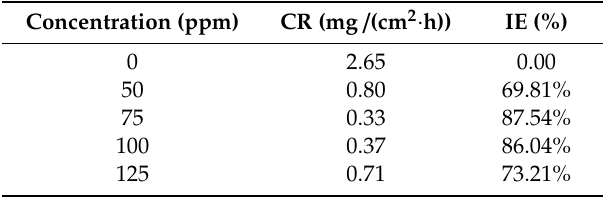
Table 1. Corrosion parameters and IE (Inhibition E ffi ciency) obtained from weight loss of iron-based